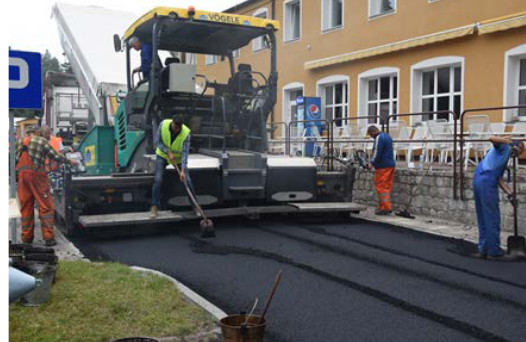
Figure 10. Applying glass geogrid on the surface of the binder course.